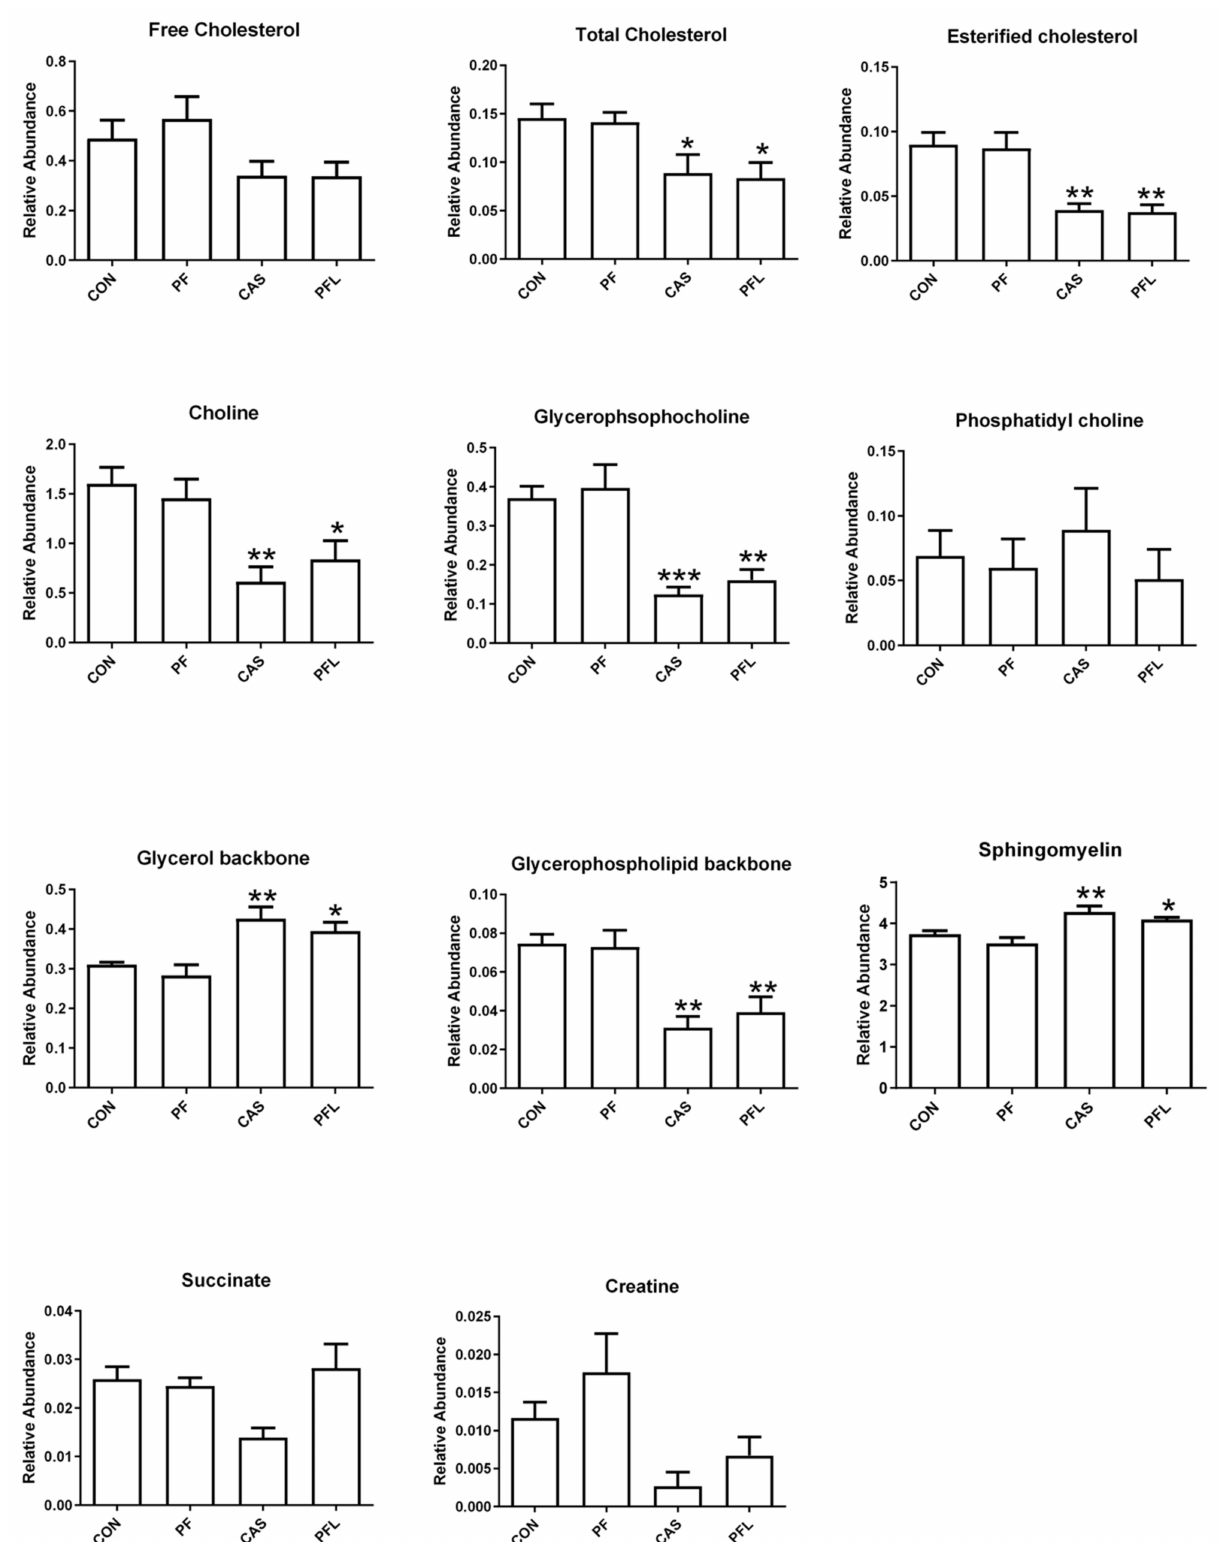
Figure 6. Relative quantification of the major differentiating metabolites in muscle based on the mean peak area of the related NMR signals. CON = Basal diet without RBF, PF = Basal diet plus prilled fat, CAS = Basal diet plus calcium soap, PFL = Basal diet plus prilled fat with lecithin. * depict the differences between control (CON) and the different RBF. Statistical icons: * p < 0.05, ** p < 0.01, and *** p <